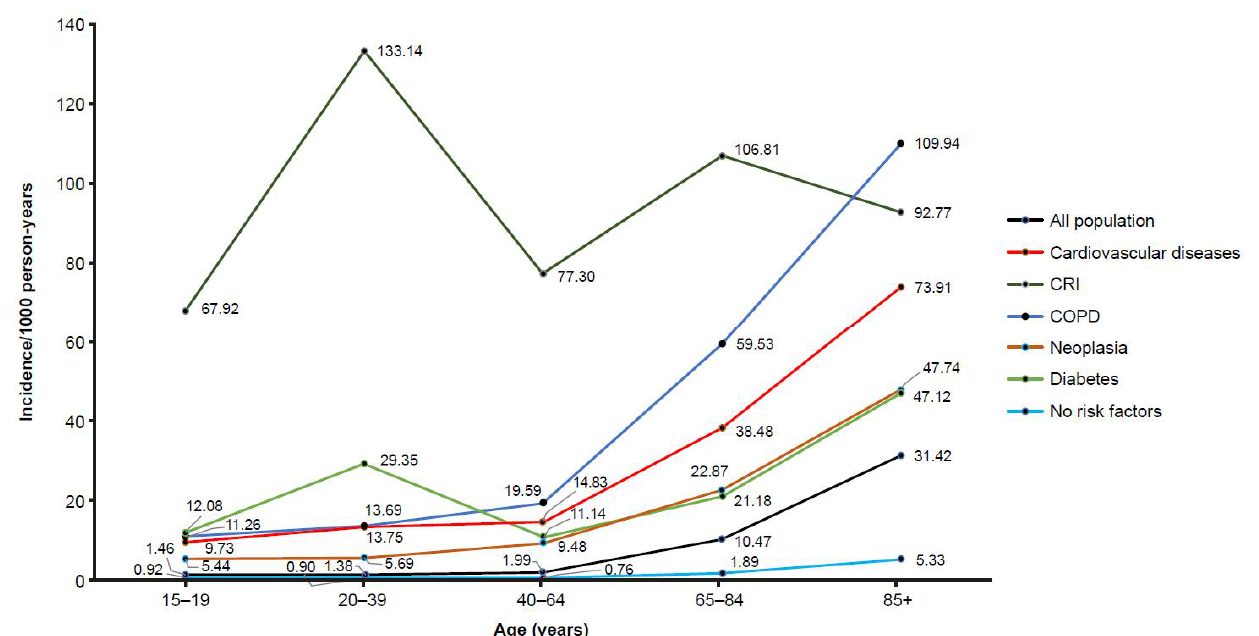
Figure 2. Annual incidence of ( A ) all-cause, ( B ) pneumococcal, and ( C ) unspecified pneumonia hos- pitalisation in adolescents and adults ≥15 years of age in Liguria, Italy (2012–2018) . CI: confidence interval.